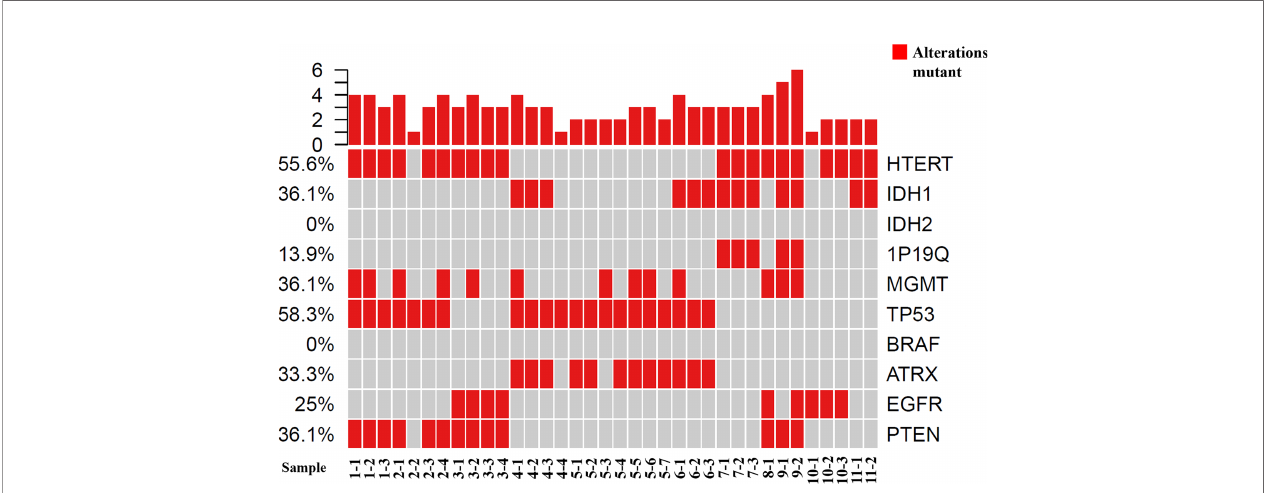
FIGURE 2 | Tumor grading and molecular phenotypes in all of the samples using GeneseeqOne pancancer gene panel (Including IDH1/2, 1p/19q, MGMT, TP53, BRAF, ATRX, EGFR and PTEN).